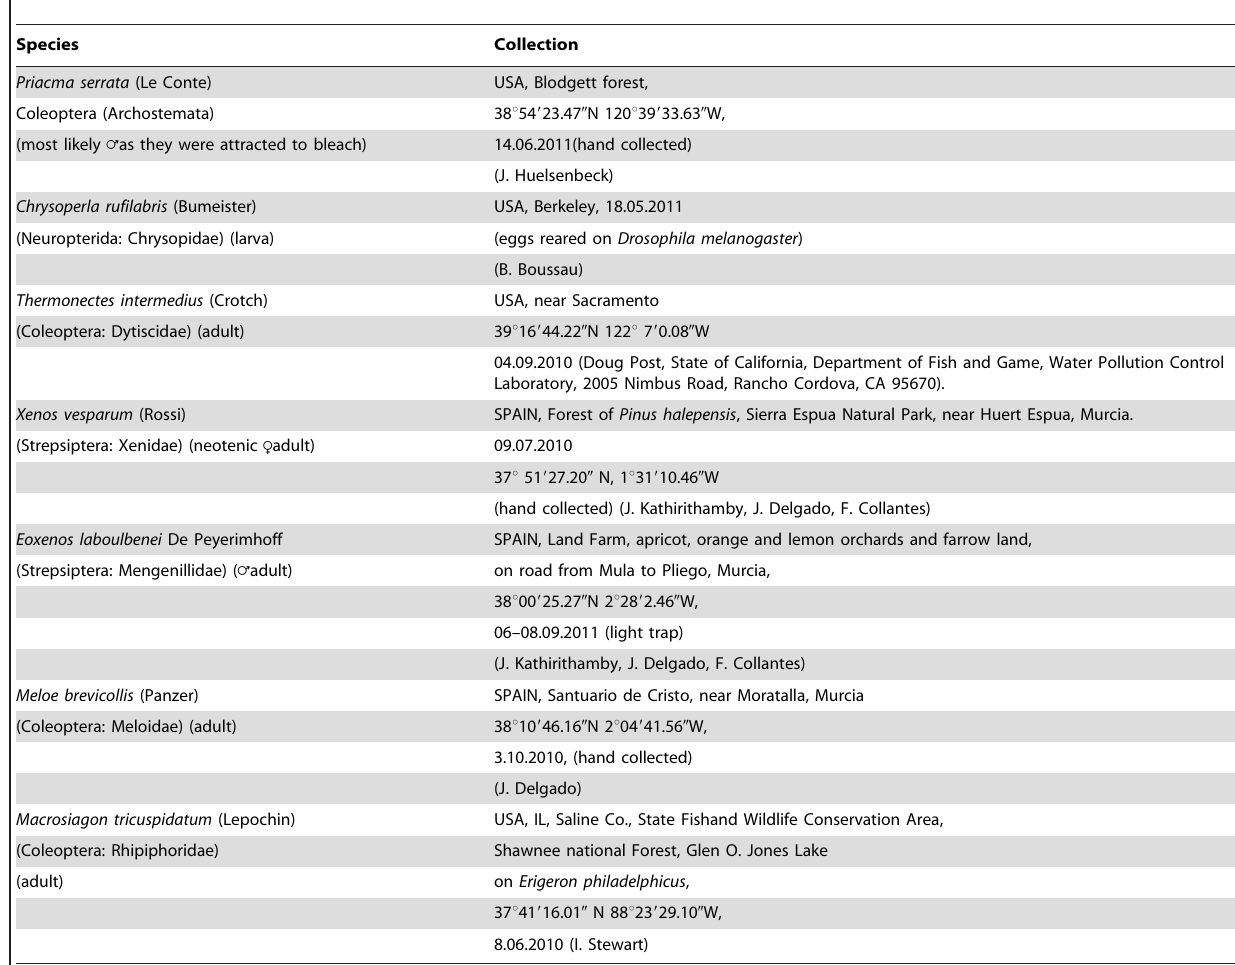
Table 1. Collection sites for specimens used in the present